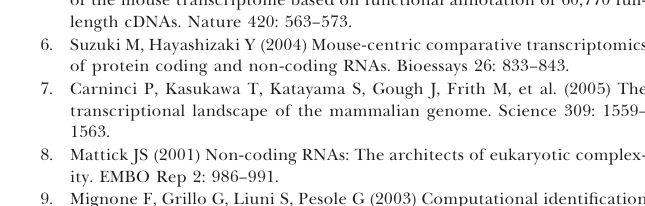
Figure S1. Prediction Reliability for Single-Feature and Multi-Feature SVMs For SVMs trained on all features (bottom right panel), there is a clear correlation between SVM output score and prediction accuracy: